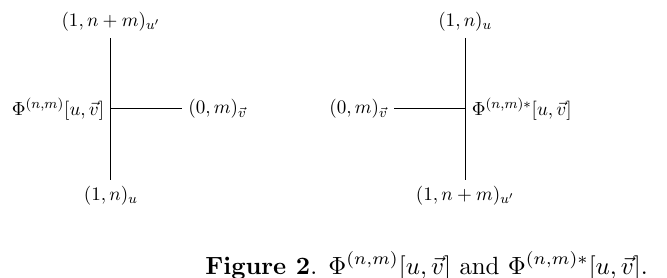
Figure 2 . (cid:8) ( n;m ) [ u;~v ] and (cid:8) ( n;m ) (cid:3) [ u;~v ].